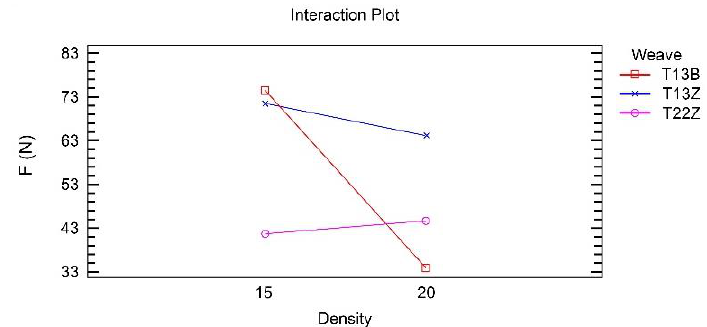
Figure 3. Interaction between density and weave in the analysis of the adhesion force for simple fabrics for z1.